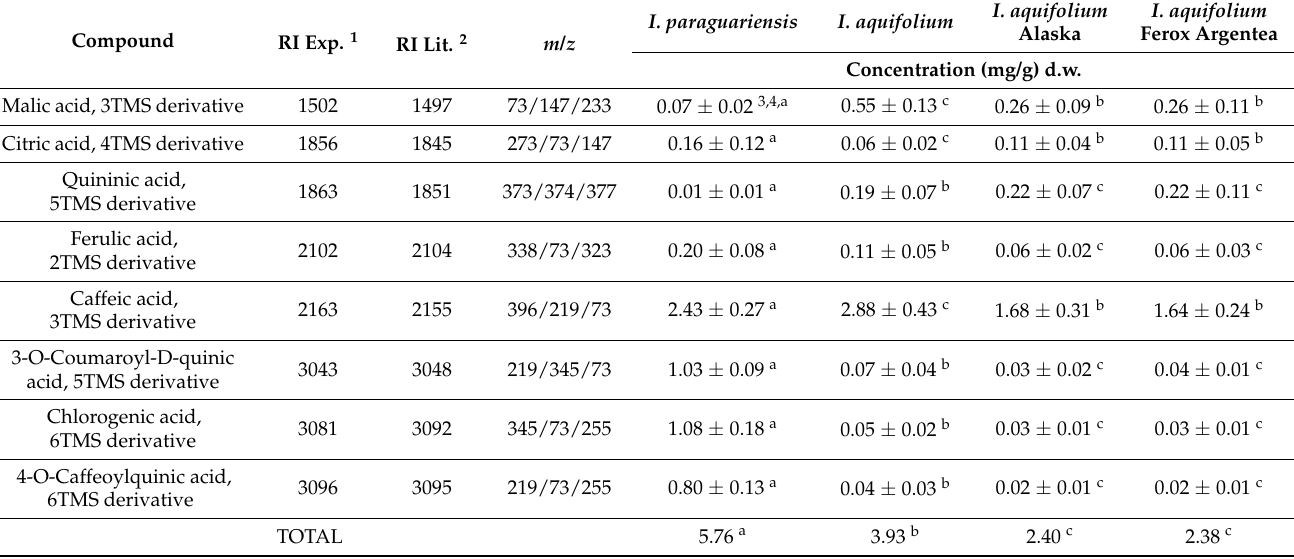
Table 4. Phenolic acid profile of I. paraquariensis and various varieties of I. aquifolium